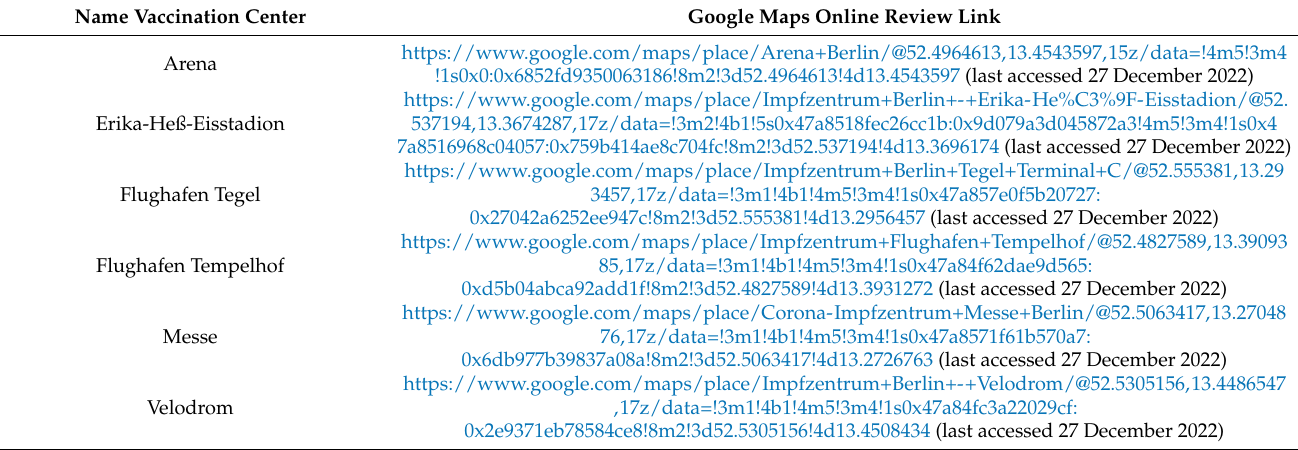
Table A1. Links to Google Maps Online Review sites for the vaccination centers